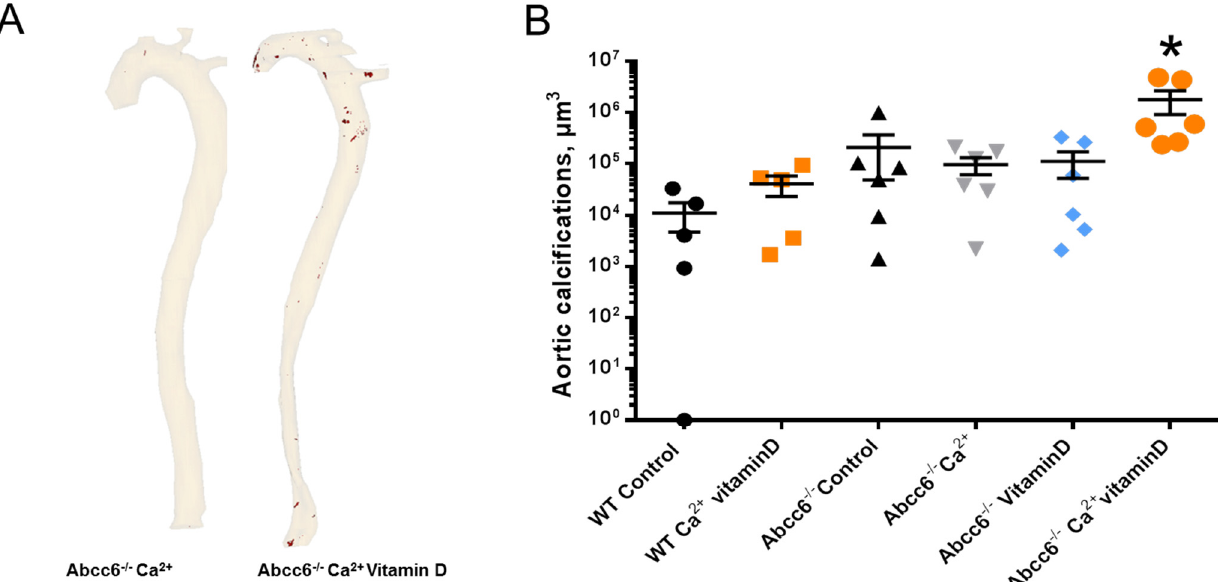
Figure 1. ( A ). Representative 3D reconstructions of micro-CT analyses in aorta of two Abcc6 − / − mice exposed to, respectively, high-calcium diet and high-calcium + vitamin D for 6 months. Calcifications (high-density areas) appear in red. ( B ). Volume of aorta calcification quantified by CT-scan in WT and Abcc6 − / − mice from all groups. * p < 0.05 vs. all other groups, Mann-Whitney test.